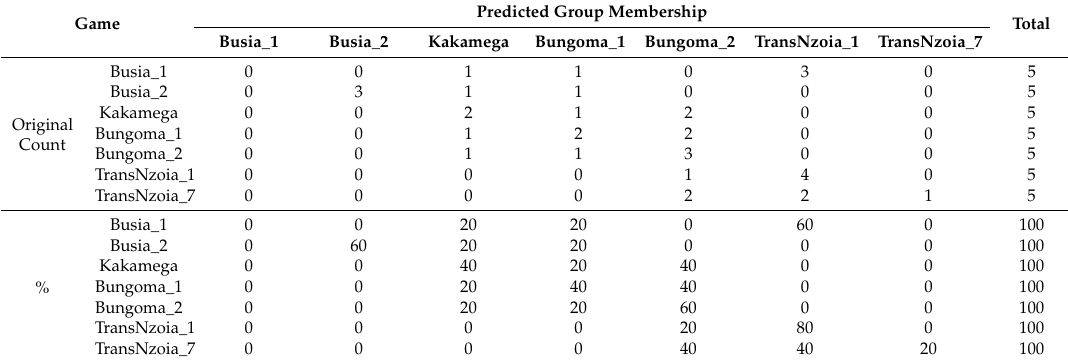
Table A15. Classification results (functions 1 through